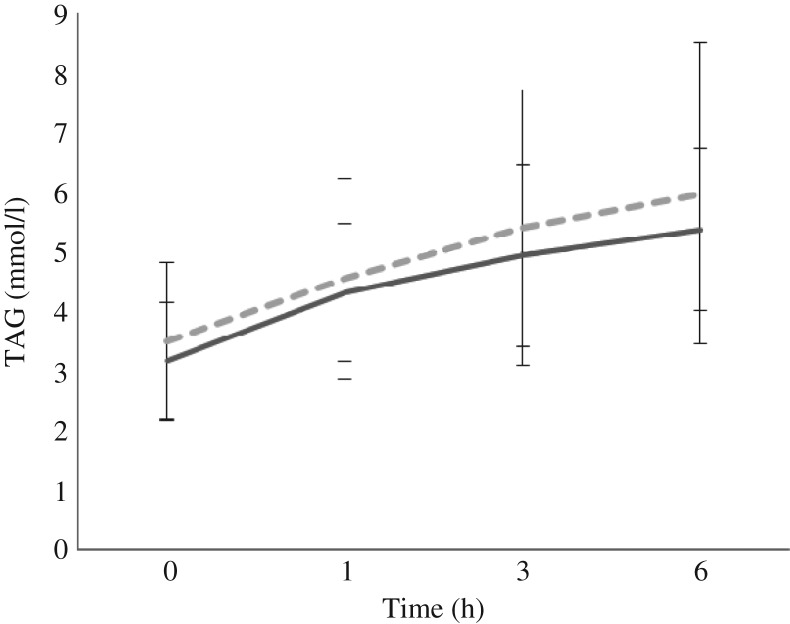
Postprandial response of serum TAG after both vegan alternative (---) and Cheddar
cheese (––) meals. Values are means, with standard deviations represented by
vertical bars (n 20). There was no difference between the
treatments but there was a significant increase over time
(P < 0·05) for all time points: 0–1, 0–3, 0–6, 1–3, 1–6, and
3–6 h.